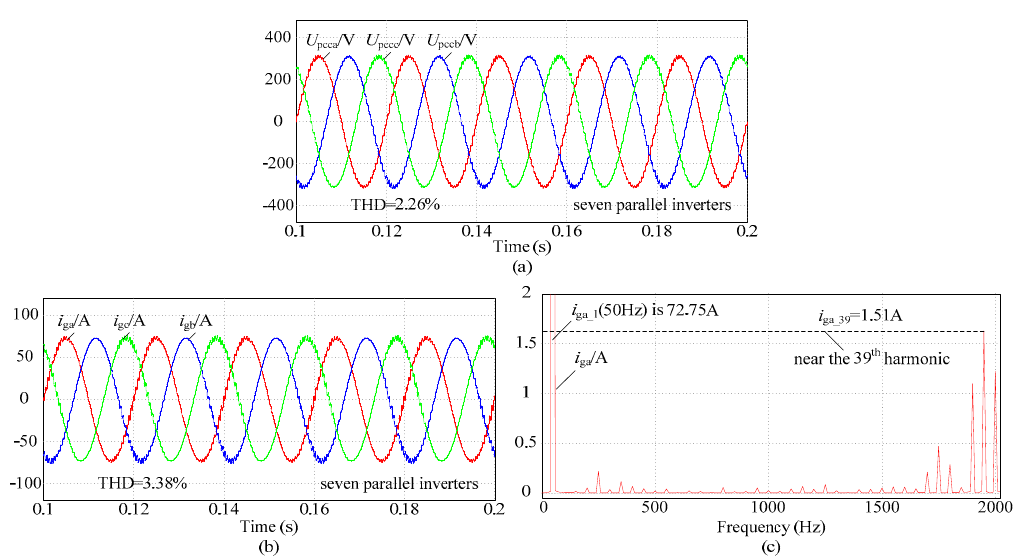
Figure 15. Simulation waveforms of PCC voltage u PCC and the grid-connected current i g in case II (seven parallel inverters). ( a ) PCC voltage u PCC ; ( b ) grid-connected current i g ; ( c ) spectrogram of grid-connected current i g .